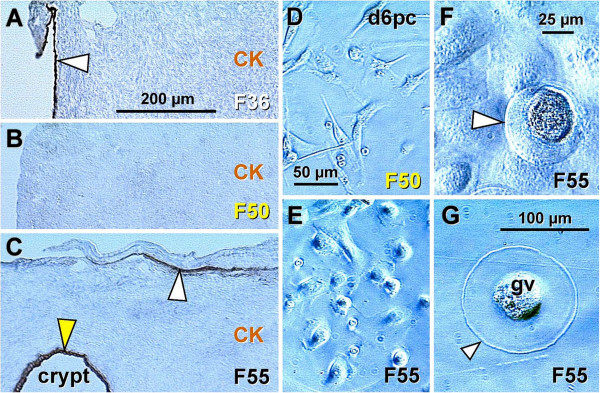
Influence of the presence vs. absence of OSC in the ovary on ovarian cultures. Occurrence of OSC in pre- and postmenopausal ovaries (A-C); note a lack of adult primordial follicles in all samples. A) Staining for CK with hematoxylin counterstain shows CK+ OSC (arrowhead) in the ovary of 36 years old woman (F36). B) Ovary of 50 years old women without OSC. C) Activity of the TA (white arrowhead) with OSC in 55 year old ovary. The OSC is also present in the cortical crypt (yellow arrowhead) in the deeper cortex. (D-G) Phase contrast from live day 6 primary ovarian cultures (d6pc). D) Ovarian culture of a 50 year old female shows only narrow fibroblasts (note lack of OSC in panel B). E) Cluster of epithelial type cells in culture from a 55 year old female (note OSC in panel C). F) Detail from another cluster of epithelial cells shows small (30 micrometers) round oocyte type cell (arrowhead) with a prominent nucleus. G) Large (120 micrometers) round oocyte type cell with germinal vesicle (gv) and thickened plasma membrane (arrowhead).